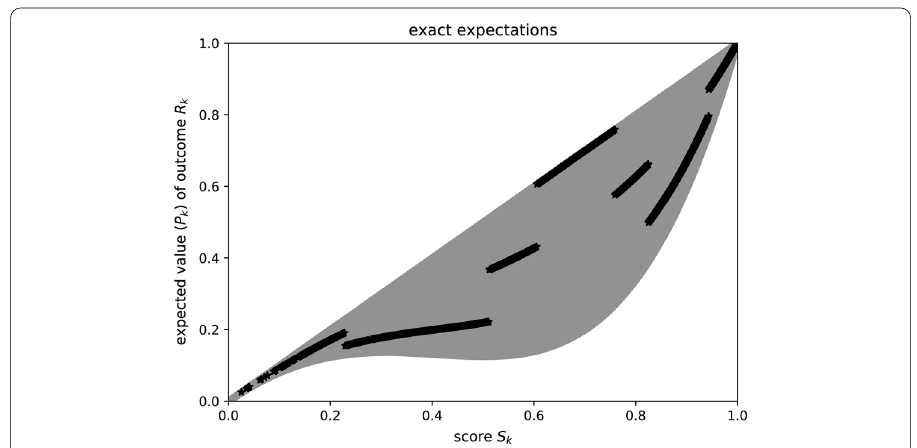
Fig. 6 Ground-truth reliability diagram for Fig.